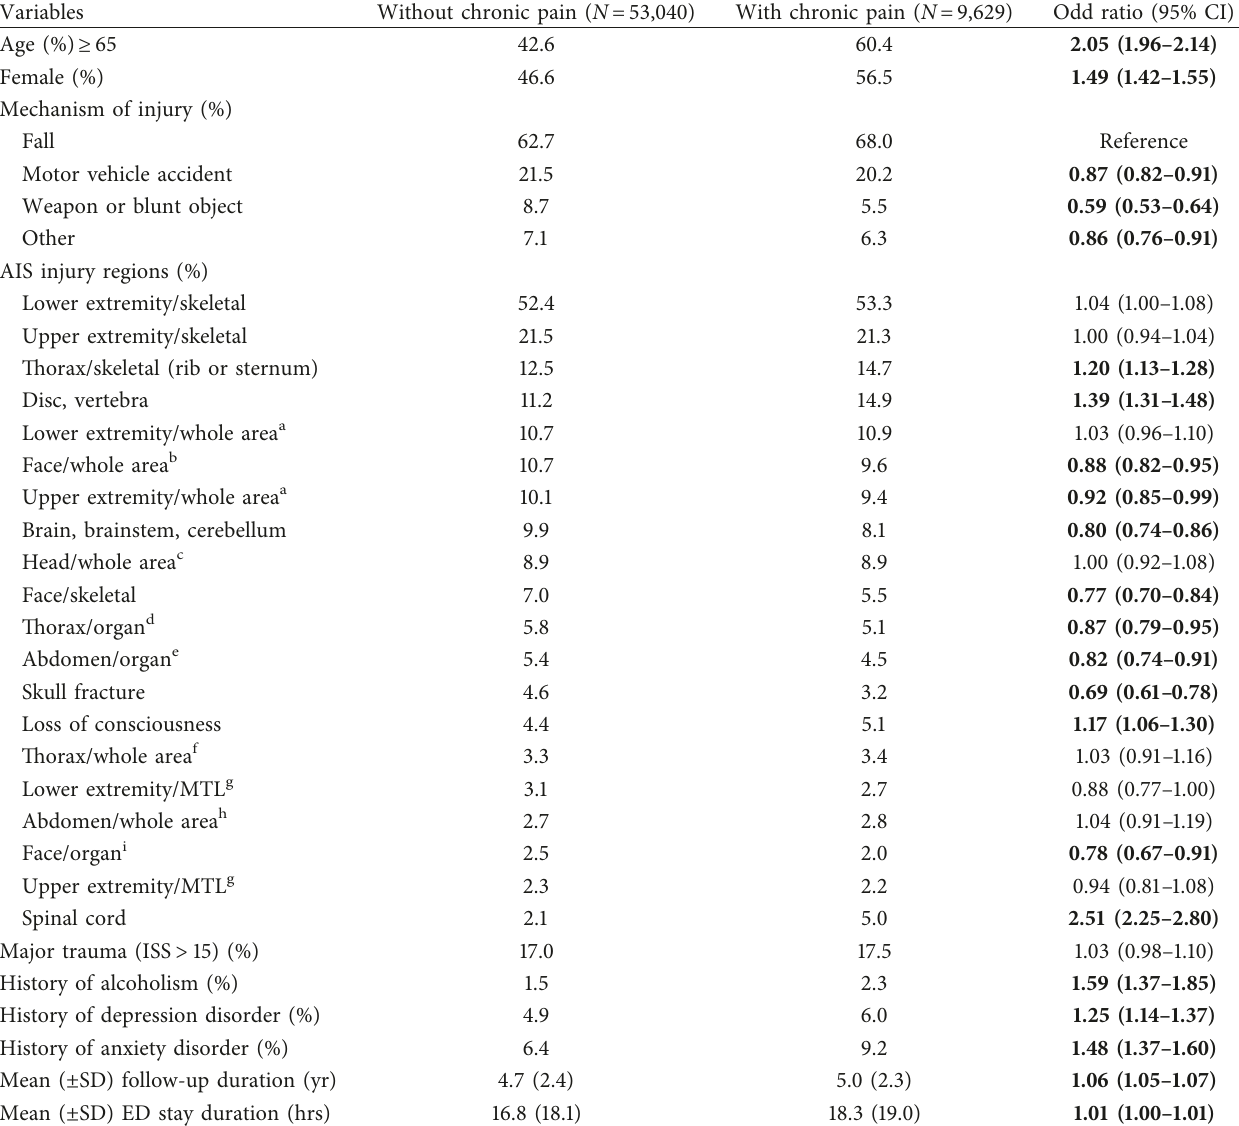
Table 3: Univariate comparisons of variables for patients with and without chronic pain in the derivation